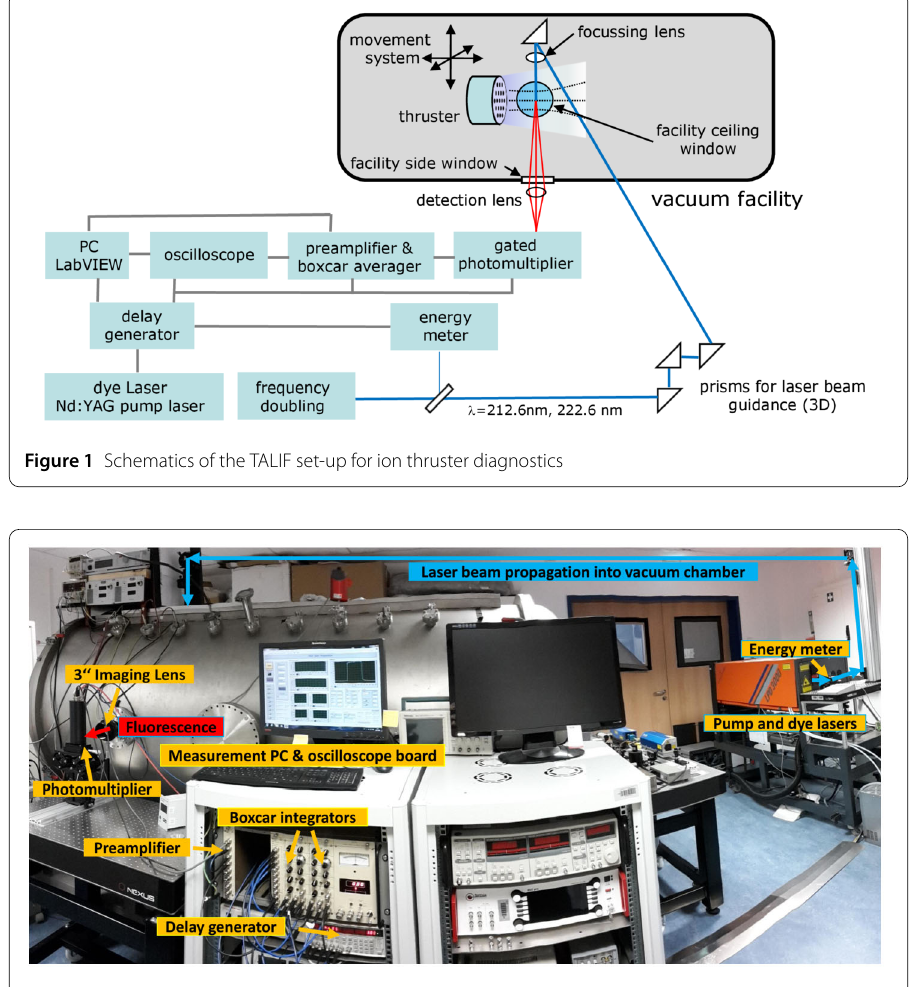
Figure 2 TALIF set-up for ion thruster diagnostics as realized in the lab at IOM. Image modified from Eichhorn et al. Paper IEPC-2019-503